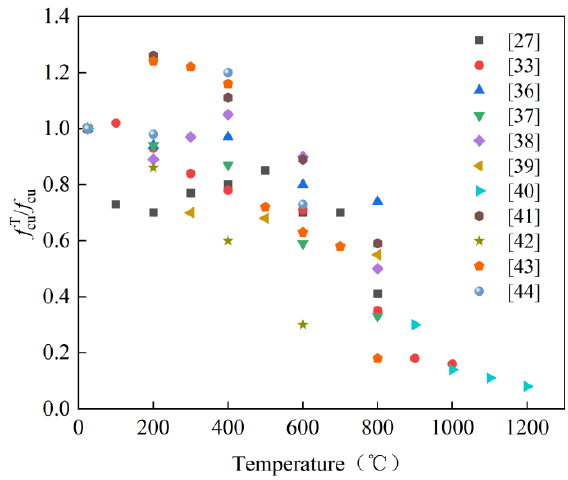
Figure 1. Relative compressive strength of steel-fiber-reinforced concrete (SFRC) after exposure to elevated temperatures [27,33,36 – 44]. elevated temperatures